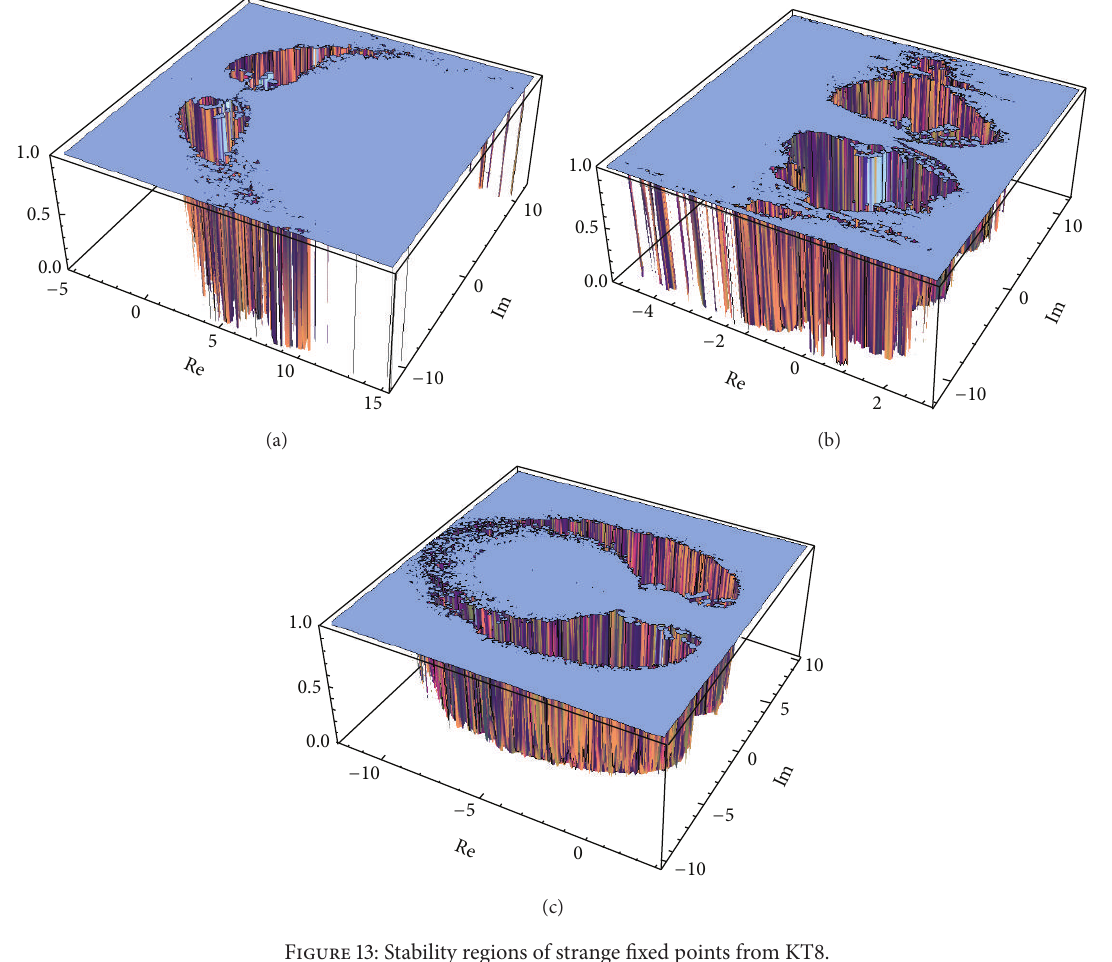
Figure 13: Stability regions of strange fixed points from KT8.